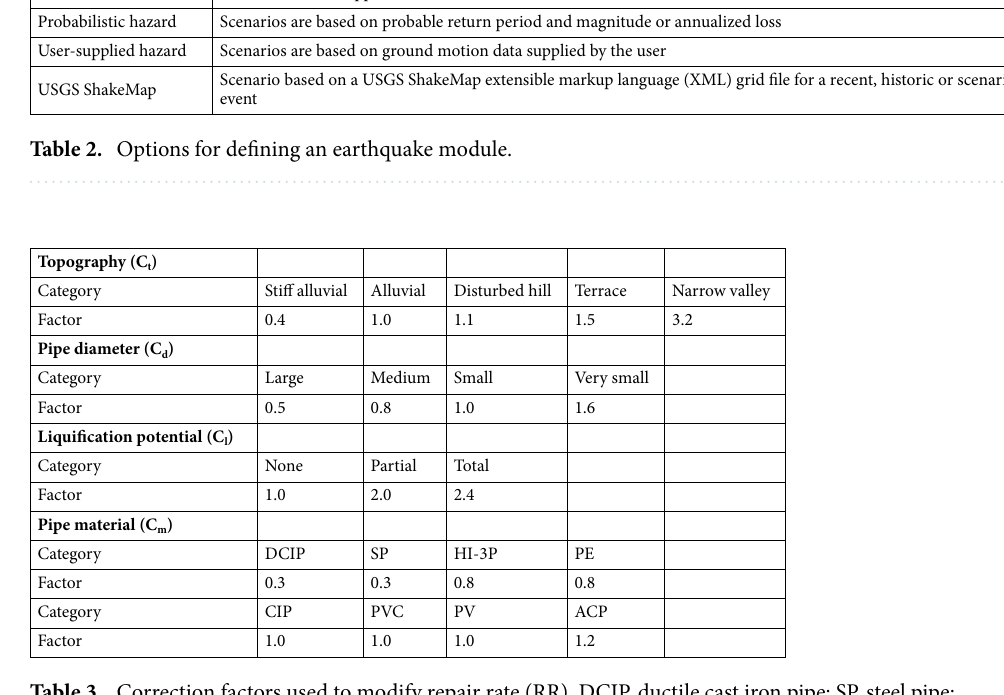
Table 3. Correction factors used to modify repair rate (RR). DCIP, ductile cast iron pipe; SP, steel pipe; HI-3P, high impact 3-layer pipe; PE, polyethylene pipe; CIP, cast iron pipe; PVC, polyvinyl chloride pipe; PV, polyvinyl pipe; ACP, asbestos cement